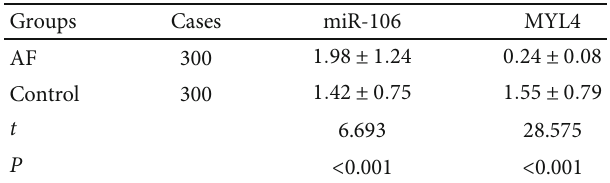
Table 2: Comparison of serum miR-106 and MYL4 levels between the two groups ( (cid:1) x ± s